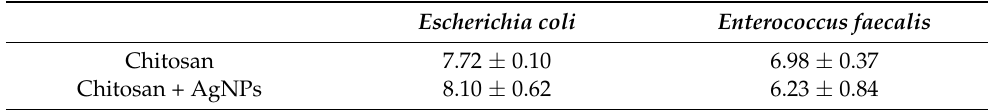
Table 2. Mean diameter of inhibition halos (mm) formed by chitosan pellets and chitosan pellets containing